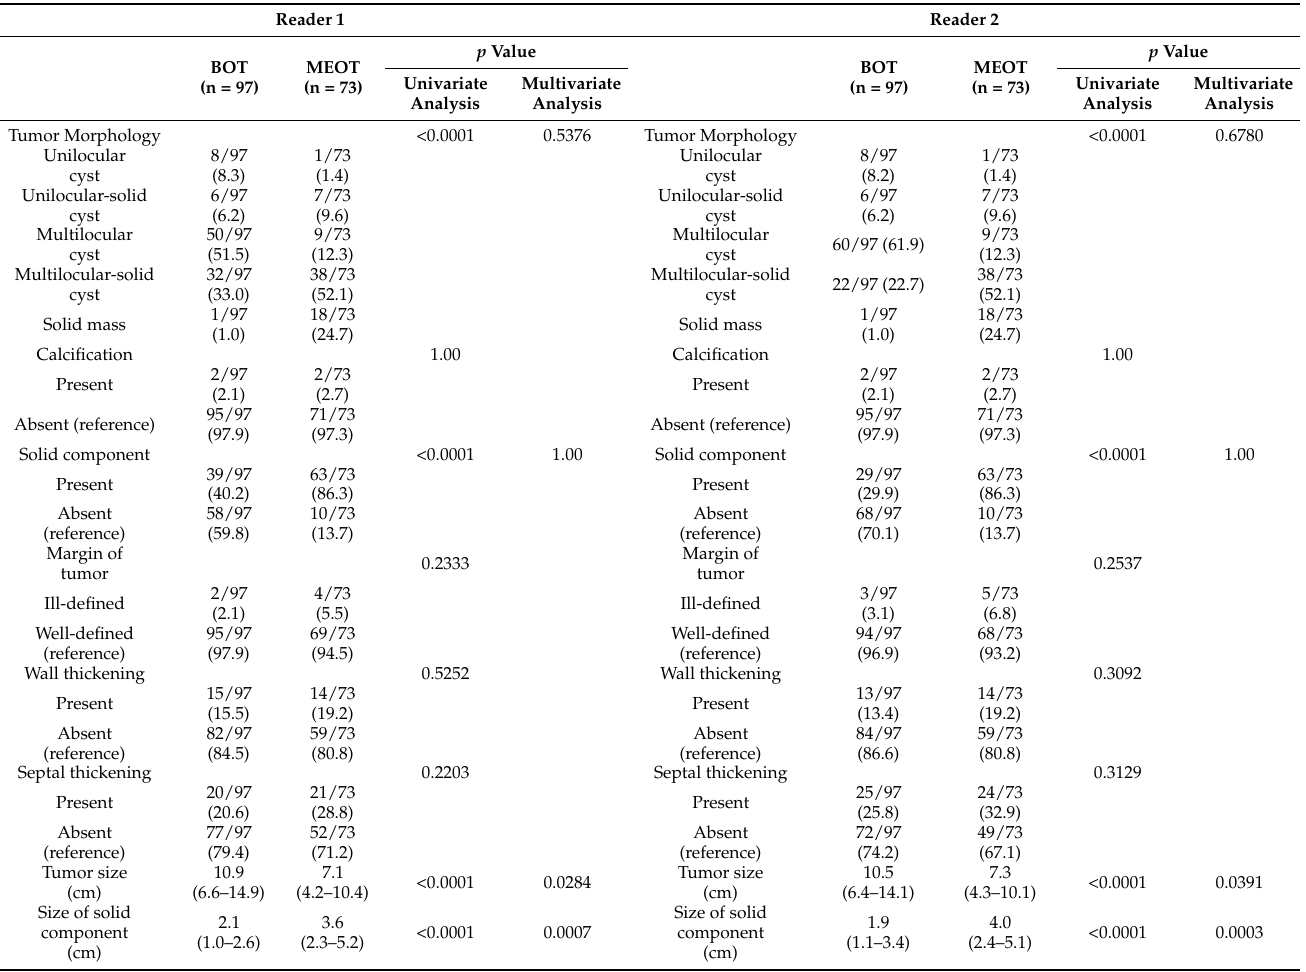
Table 2. Comparison of CT findings between BOTs and